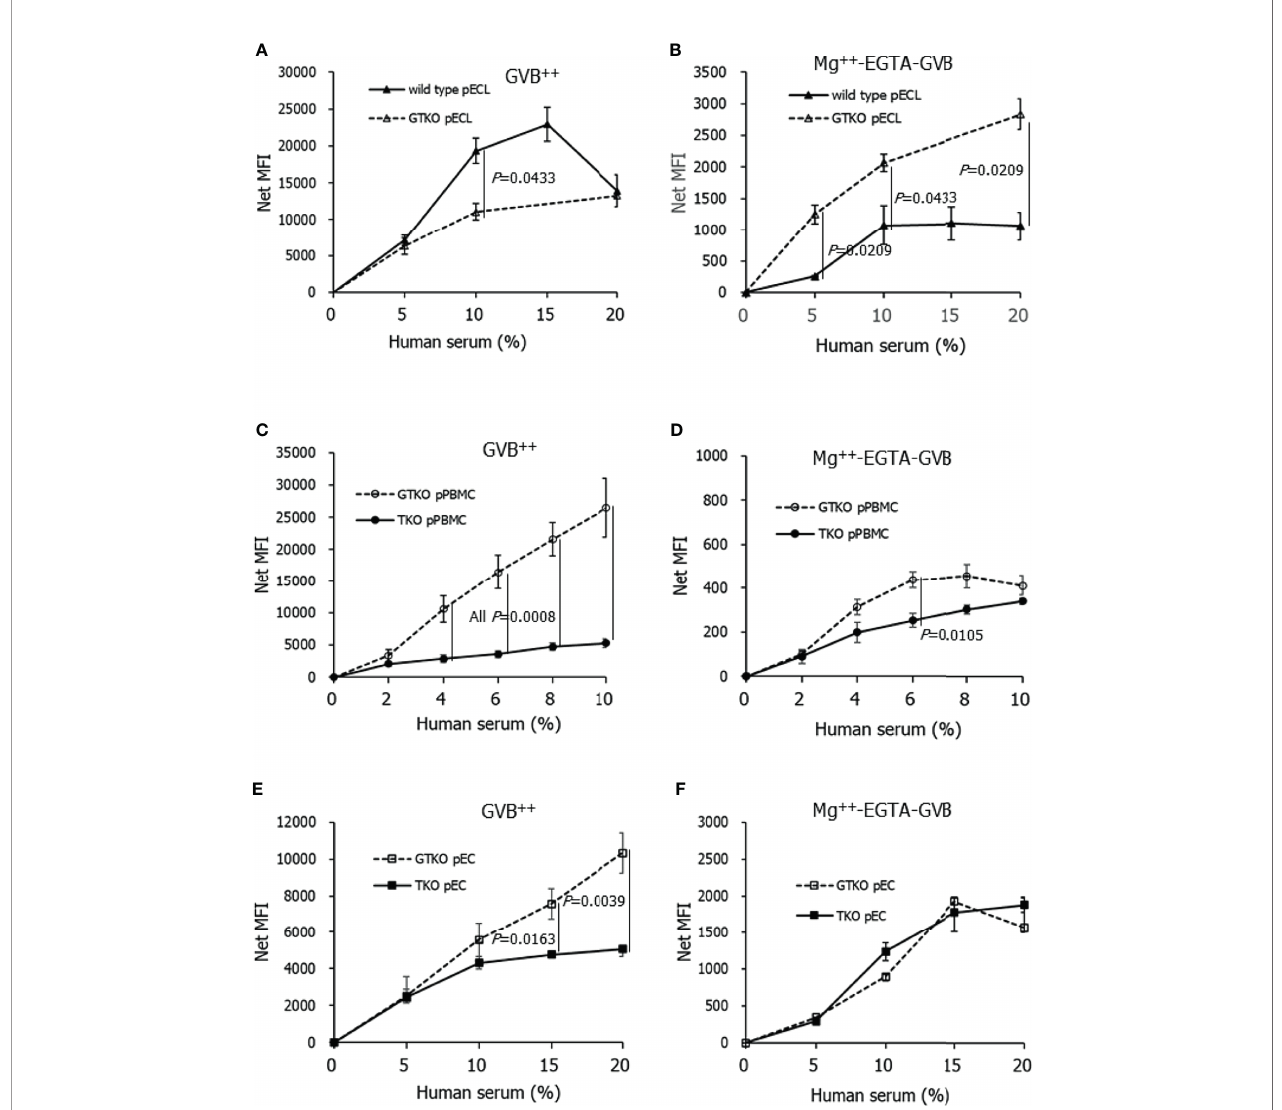
FIGURE 2 | C3 deposition on porcine cells after incubating in Ca ++ enriched gelatin veronal buffer (GVB ++ ) (A, C, E) or Mg ++ -EGTA-GVB (B, D, F) with various concentrations of human serum. After incubation, C3 on the cells were stained using fl uorescein conjugated anti-C3 antibodies and analyzed using fl ow cytometry. C3 deposition on the cells by human serum was expressed as a net mean fl uorescent intensity (MFI) by subtracting the MFI of the sample without human serum. Wild-type and alpha-1,3-galactosyltransferase gene-knockout ( GT KO) porcine endothelial cell lines ( pECL, A, B) , porcine peripheral blood mononuclear cells ( pPBMC, C, D) , and primary porcine endothelial cells (pEC) from GT KO pigs and from triple knockout (TKO) pigs (E, F) were used in the